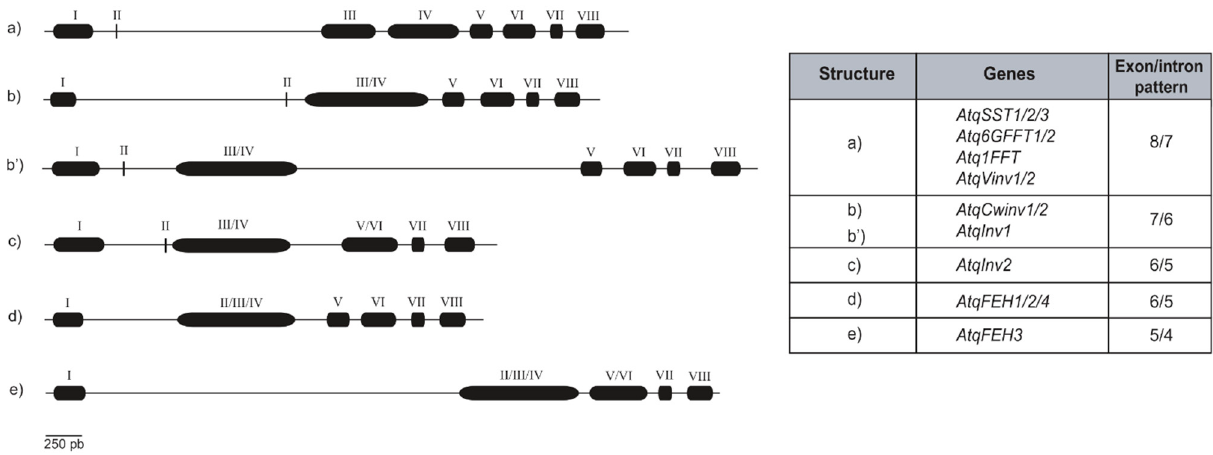
Figure 1. Schematic representation of the genomic structures of A. tequila PGHF32 encoding genes. Introns are represented by straight lines and exons with solid boxes. Roman numerals (I-VIII) from left to right identify each exon. Scale bar represents 250 base pairs. The table summarizes the genes and their exon/intron structure.